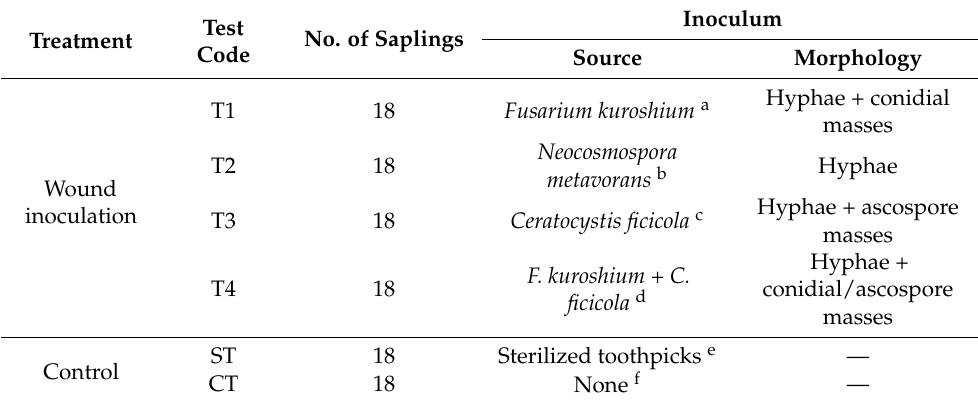
Table 1. The inoculation of Ficus carica saplings with different isolates.